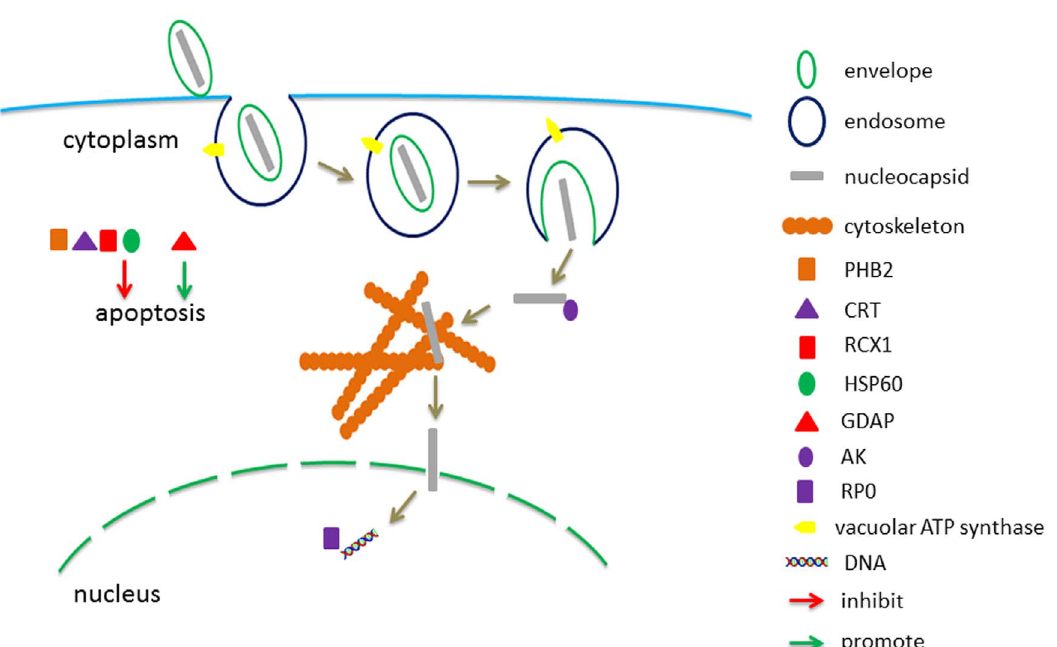
Fig. 5. Hypothesized roles of the identified BmNPV-binding proteins of B. mori in the virus infection process. The envelope contained BmNPV nucleocapsid binded to the cytomembrane, then endocytosis was triggered, and vacuolar ATP synthase catalytic subunit A and subunit B on the endosome membrane could promote the fusion of the envelope and endosome to release the nucleocapsid into the cytoplasm. The released nucleocapsid was transported into the nucleus with the assistance of cytoskeleton (Actin, PGK and En). The virus DNA was released in the nucleus, and RP0 could regulate RNA expression of BmNPV. In the infection process, GDAP would trigger apotosis to inhibit BmNPV infection, while PHB2, CRT, RCX1 and HSP60 had the opposite effects.